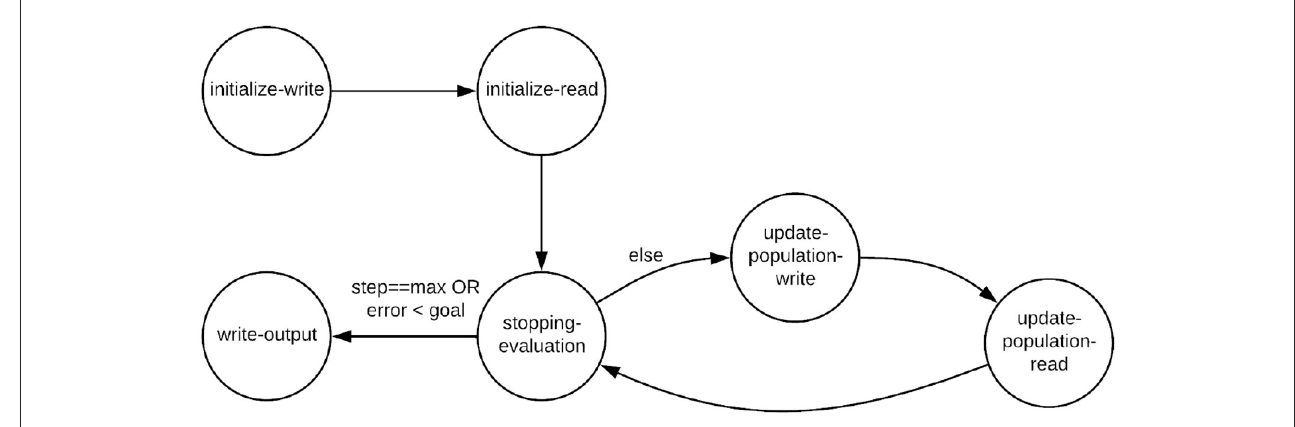
FIGURE2 Mode transition graph for the PSO Core